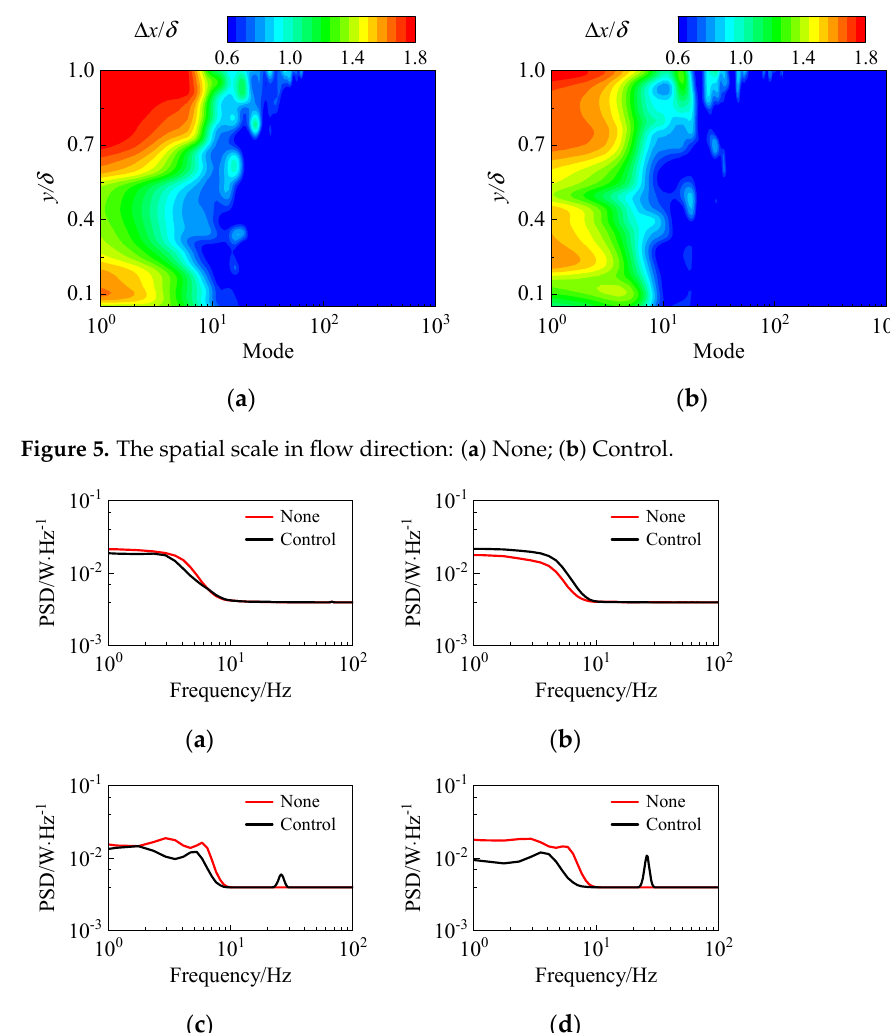
( b ) Figure 4. The profiles of ( a ) information entropy and ( b ) relative entropy. Based on the information entropy, Kullback et al. [22] proposed the concept of rela- tive entropy, which can measure the disparity between two random distributions. The specific expression can be written as: (